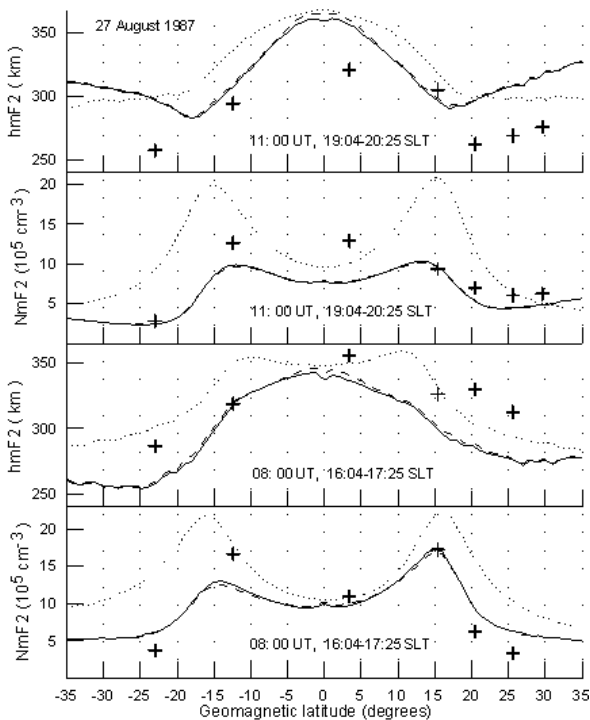
Fig. 17. Observed (crosses) and calculated (lines) hmF 2 and NmF 2 at 08:00 UT (two lower panels) and 11:00 UT (two upper panels) on 27 August 1987. The measured hmF 2 and NmF 2 are taken from the ionospheric sounder station listed in Table 1. The curves are the same as in Fig.